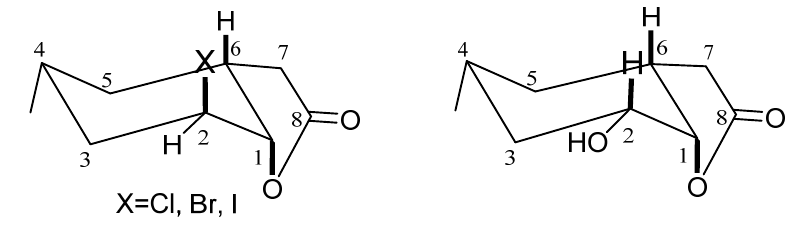
Figure 1. Structure of lactones 2 – 5 .